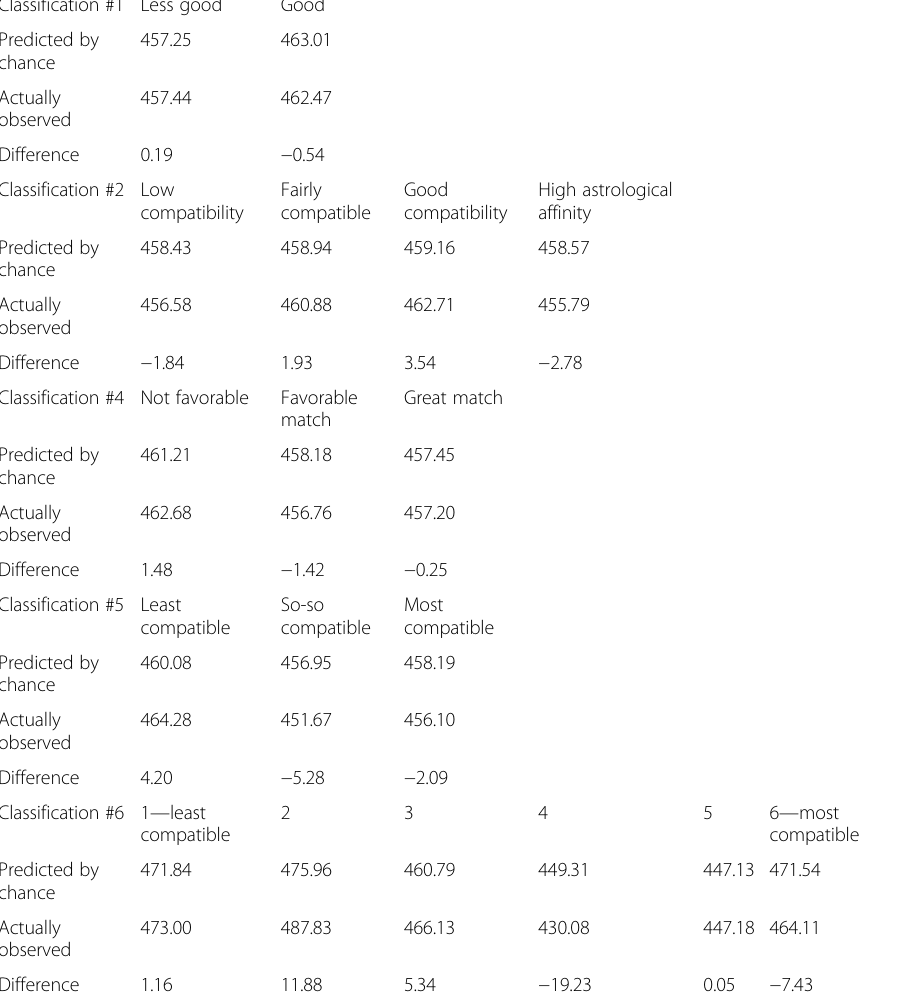
Table 3 Predicted and observed mean number of marriages, by zodiac-sign compatibility